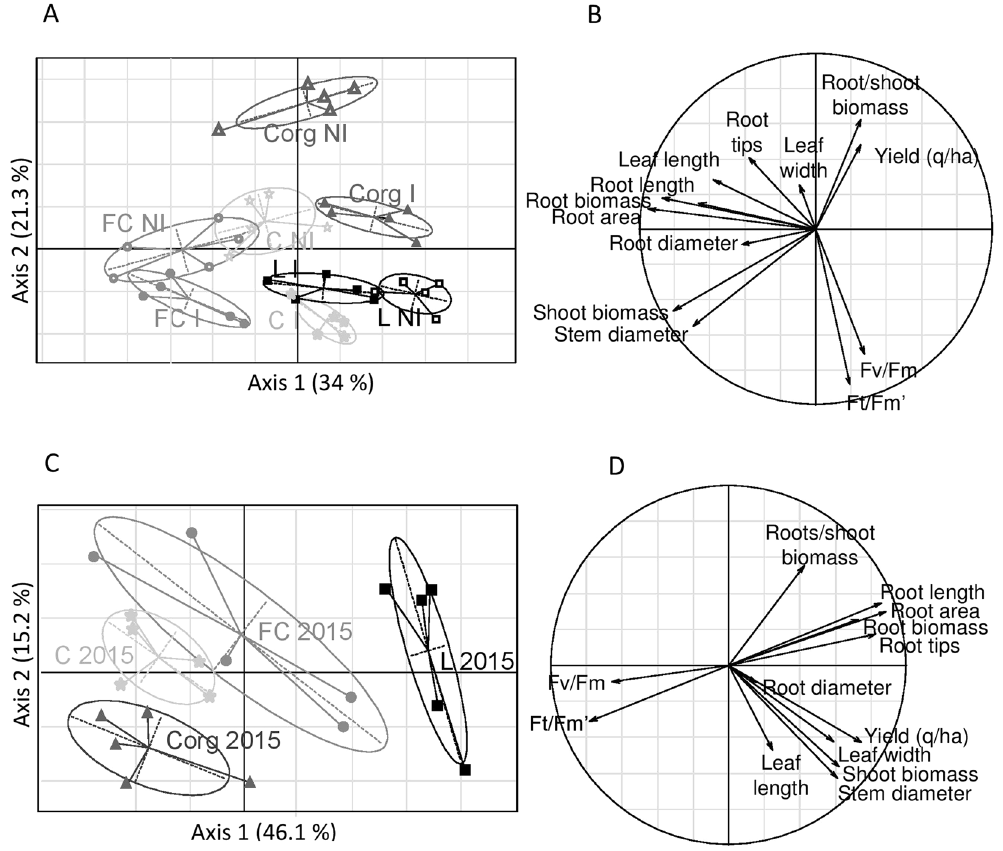
Figure 2. Principal component analysis (PCA) of morphological, photosynthetic and yield characteristics ( A , B ) or percent modification of these characteristics by A . lipoferum CRT1 seed coating within blocs ( C , D ). Plants of the 2015 experimental setup (field LC, circles; L, squares; C, stars and Corg, triangles also distinguished by different shades of grey) originating from PGPR-coated (I) or mock-coated (NI) seeds were assessed at the 6-leaf stage except for yield was estimated at the end of the growing season. Four plants were randomly analyzed in each bloc for their morphological and photosynthetic characteristics and the values averaged to yield a single input bloc value for PCA computation. Yields were measured once per bloc. A different shade of grey is given for each experimental